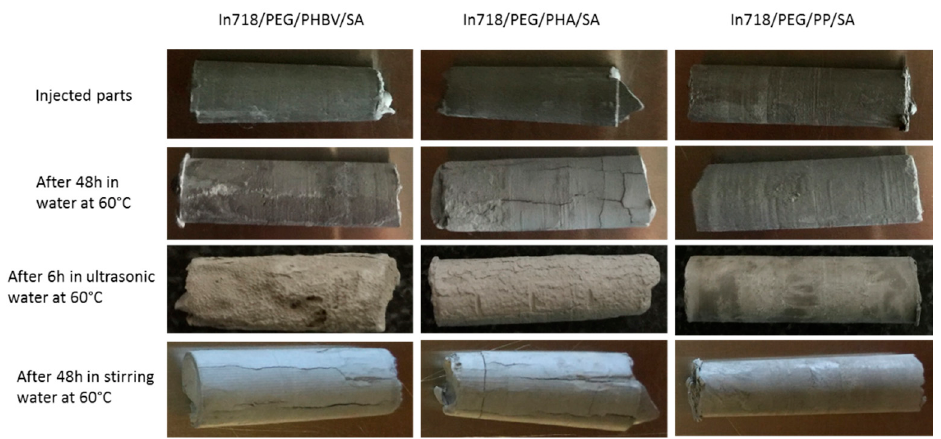
Figure 6. Images of the different samples after injection, after 48 h of debinding in water at 60 °C, after 6 h of debinding in ultrasonci water at 60 °C, and after 48 h of debinding in stirring water at 60 °C.